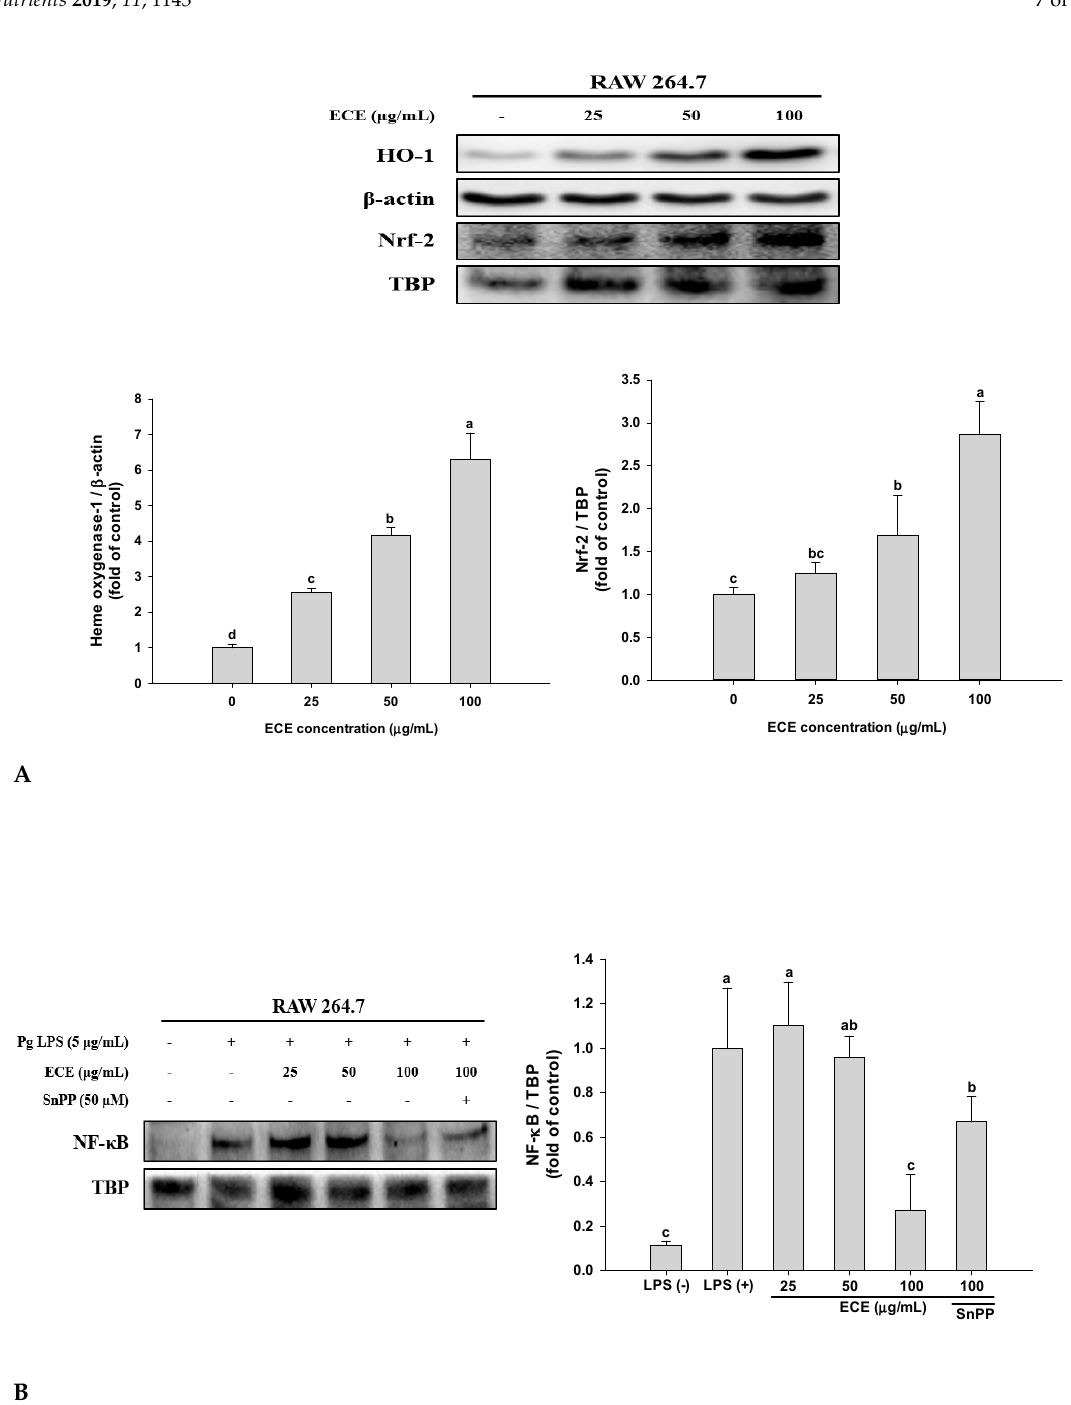
Figure 3. E ff ects of ECE on ( A ) Nrf-2 / HO-1, and ( B ) NF- κ B expression in P. gingivalis LPS-stimulated RAW 264.7 macrophages. Cells were pre-treated with samples and SnPP for 3 h and treated with P. gingivalis LPS (5 µ g / mL) for 24 h. The protein level of HO-1 was analyzed using Western blot and normalized to that of β -actin. Nuclear protein lysates were prepared for the Nrf-2 and NF- κ B analysis and normalized to that of TBP. Data are presented as mean ± SD and bars with di ff erent letters indicate significant di ff erences at p < 0.05. ECE: Ecklonia cava extract, LPS: lipopolysaccharide, Nrf-2: nuclear factor (erythroid-derived 2)-related factor 2, HO-1: heme oxygenase-1, SnPP: tin-protophophyrin IX, a HO-1 inhibitor, NF- κ B: nuclear factor- κ B, TBP: TATA-binding protein. NF- κ B is a key transcription factor that elicits pro-inflammatory cytokine release and inflammatory responses and P. gingivalis LPS leads to marked increase of nuclear NF- κ B translocation [28]. As